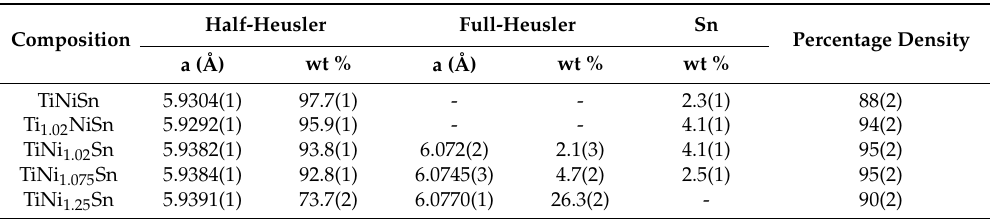
Table 1. Half- and full-Heusler lattice parameters (a), weight percentages of the phases present and percentage density for the TiNi 1+y Sn samples and Ti 1.02 NiSn.